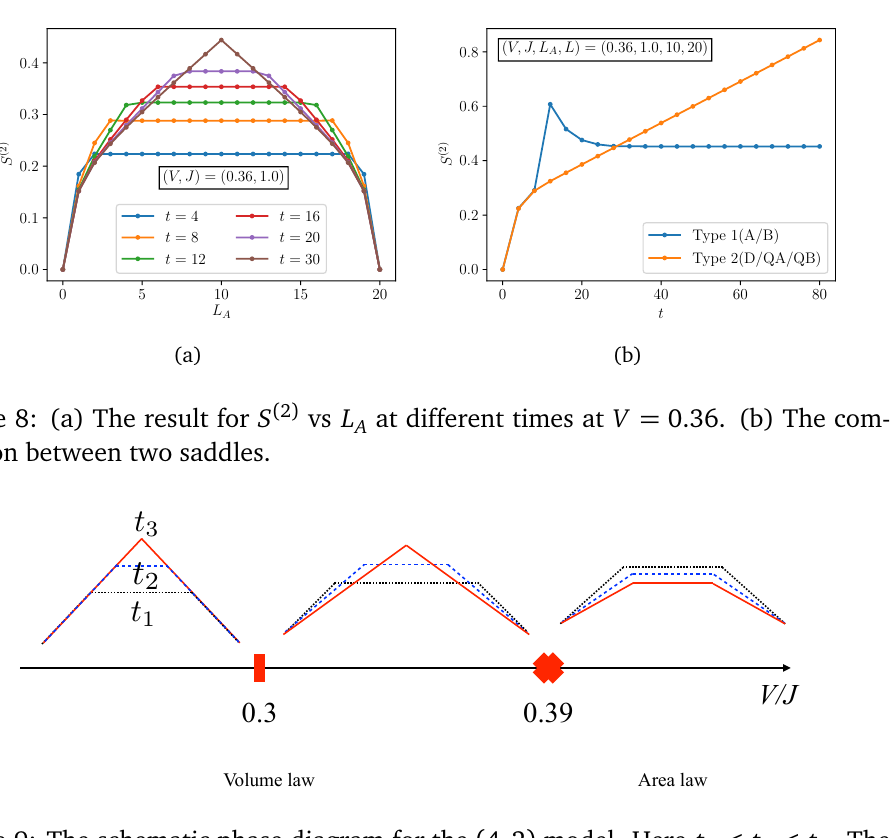
Figure 9: The schematic phase diagram for the ( 4,2 ) model. Here t phase transition occurs at V / J =